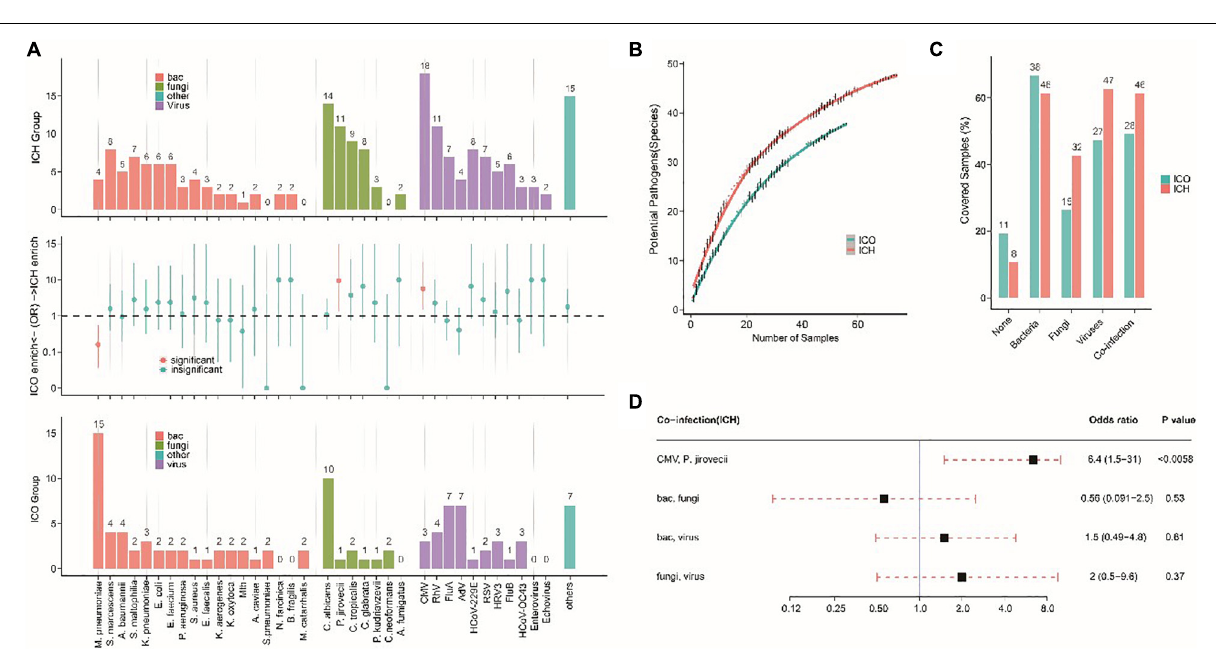
FIGURE 4 | Different microbial etiologies in ICO and ICH patients with pneumonia. (A) Spectra of potential pathogens in ICH (upper) and ICO (lower) patients. Middle panels indicate pathogens that were significantly overrepresented (red dots, P < 0.05) in ICH (above the dotted line) or ICO patients (below the dotted line). (B) Numbers of potential pathogens identified in cumulative pneumonia cases. Random resampling of the cases at each data point was performed 50 times to generate the 95% intervals (thin lines at each point). Blue (ICO) and red (ICH) lines indicate the median value from 50 random replicates. (C) Distribution of different types of microbial etiology. (D) Potential coinfections in ICH patients. The black box indicates the median odds ratio; the red dotted line indicates the 95% confidence interval. P -values were calculated by Fisher’s exact tests. bac, bacteria; cul, culture; ICO, immunocompetent host; ICH, immunocompromised host; Mtb, Mycobacterium tuberculosis ; CMV, cytomegalovirus; Flu A, influenza virus type A; Flu B, influenza virus type B; RhV, rhinovirus; AdV, adenovirus; RSV, respiratory syncytial virus; HRV3, human respiratory virus type 3; HCoV, human coronavirus OC43; hMPV, human